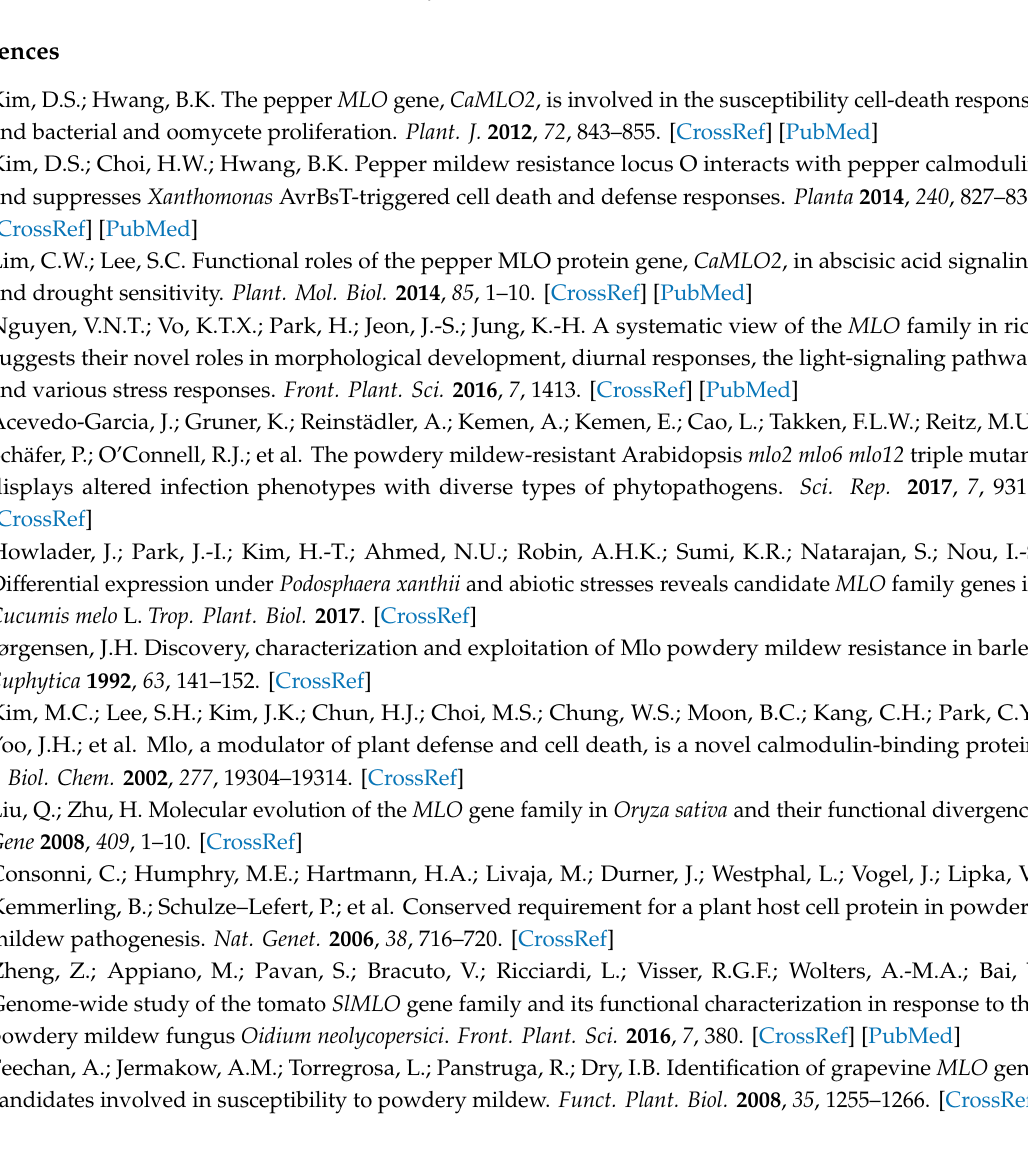
Figure S1: Chromosomal localization, gene clusters, and gene duplication of MLO genes. Table S1: MLO genes in di ff erent plant species and their sequence characteristics. Table S2: 53 pairs of homologous genes and their base substitution